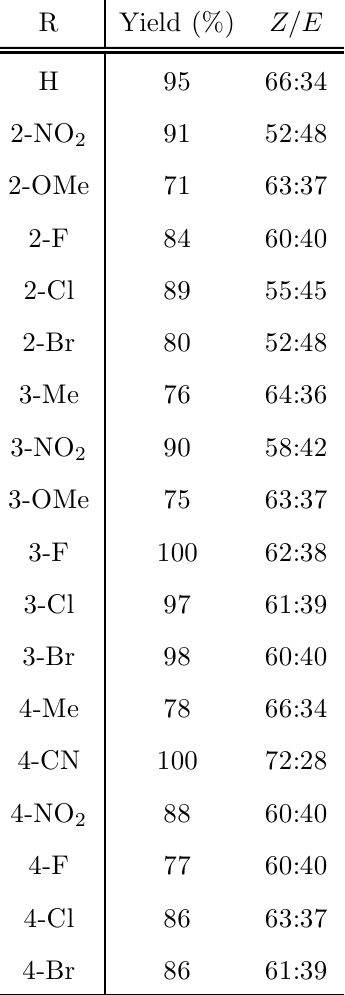
Table 1 Yields and Z=E ratios for the reaction of 1,3-dioxolan-2-yl-methyltriphenylphosphonium salts with o -, m -, p - substituted